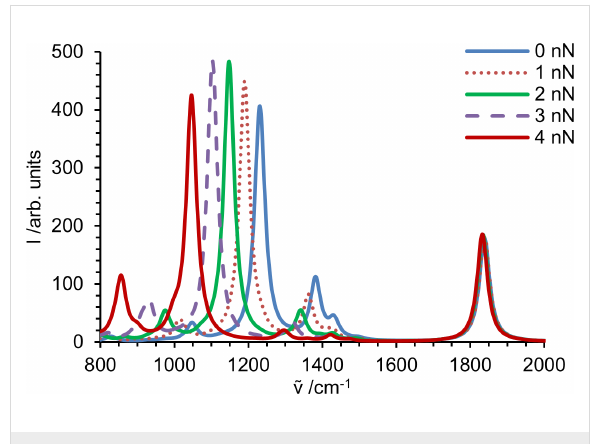
Figure 5: Intensities in fingerprint region of the infrared spectrum ob- tained for propyl propanoate. Spectral lines are broadened with a Lorentzian (34 cm − 1 at FWHM) and summed up, yielding the spec- trum of a stretched